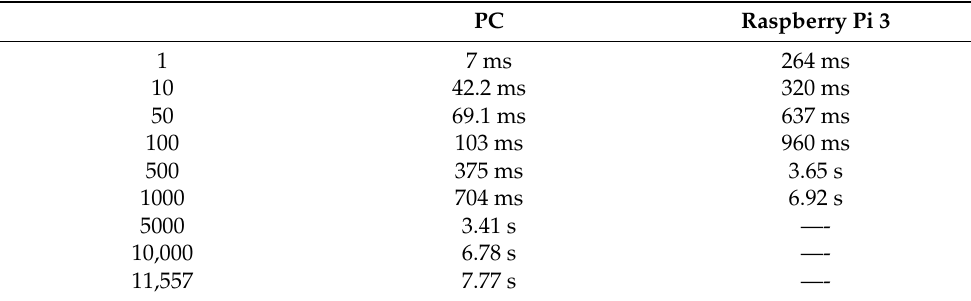
Table 1. Overall execution